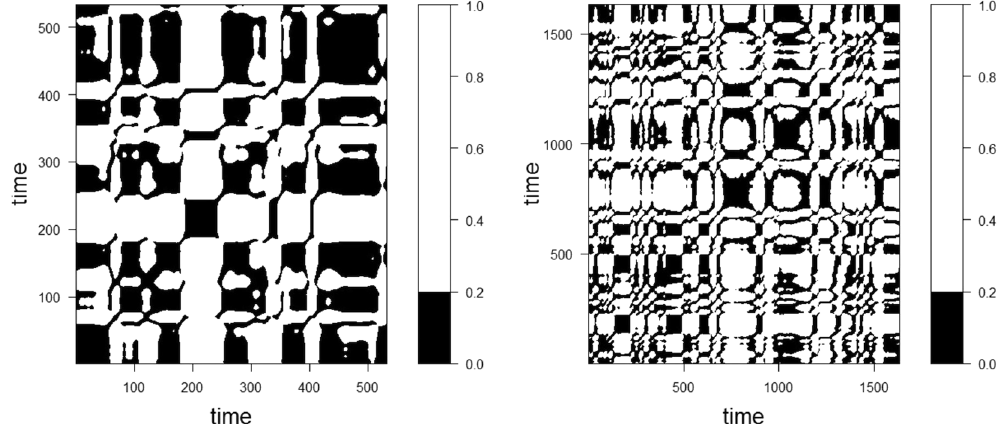
Figure 2. Recurrence plots of time series for landmark time intervals with a high risk of hypoglycemia (left) and a high risk of both hypo-and hyper-glycemia (right). Note that the plot is symmetric about the diagonal running from the lower left to the upper right.